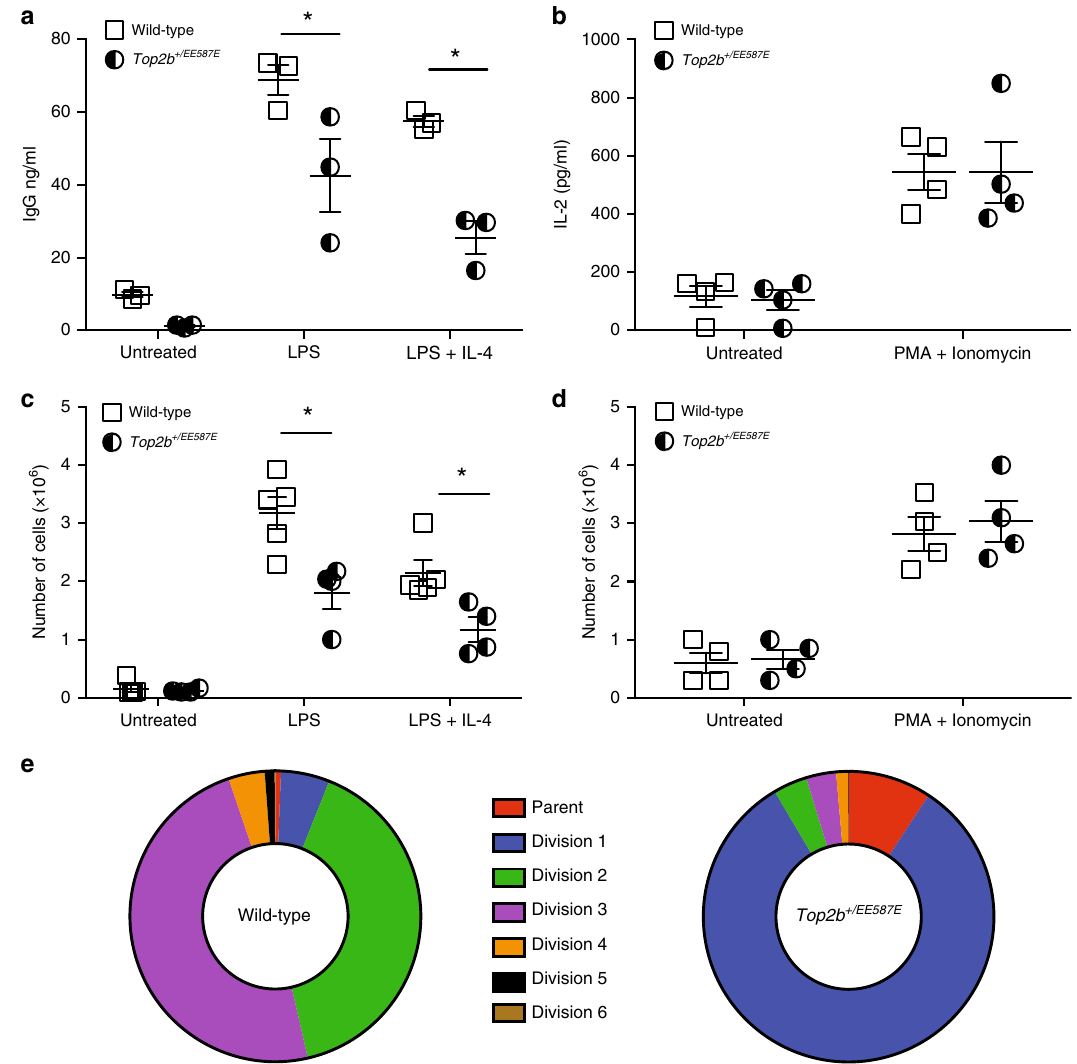
Fig. 7 Heterozygous mutant mice fail to respond to in vitro stimulation, while T activation is not affected. Splenic B cells ( a , c ) and T cells ( b , d ) were isolated from Top2b + /EE587E and wild-type littermates and stimulated in vitro for measurement of cell counts and protein secretion. Stimulated B cells showed reduced secretion of immunoglobulin in the presence of mutated Top2b ( a , n = 3 mice/group), but T cells secreted IL-2 in equivalent amounts ( b , n = 4 mice per group). c Mutant B cells demonstrated reduced proliferation compared to wild-type littermates ( n = 5 WT and 4 mutant mice per group), whereas T cells ( d , n = 4 mice per group) proliferated similarly between the two groups. (All performed in triplicate. * p < 0.05 by Student ’ s t test). e Failure to proliferate is associated with an early arrest. Splenic B cells were isolated from Top2b + /EE587E and wild-type littermates, stained with CFSE, and stimulated in vitro LPS (25 μ g/mL) ± IL-4 (10 ng/mL). Propidium iodide exclusion was used to determine the percent of viable cells at each stage